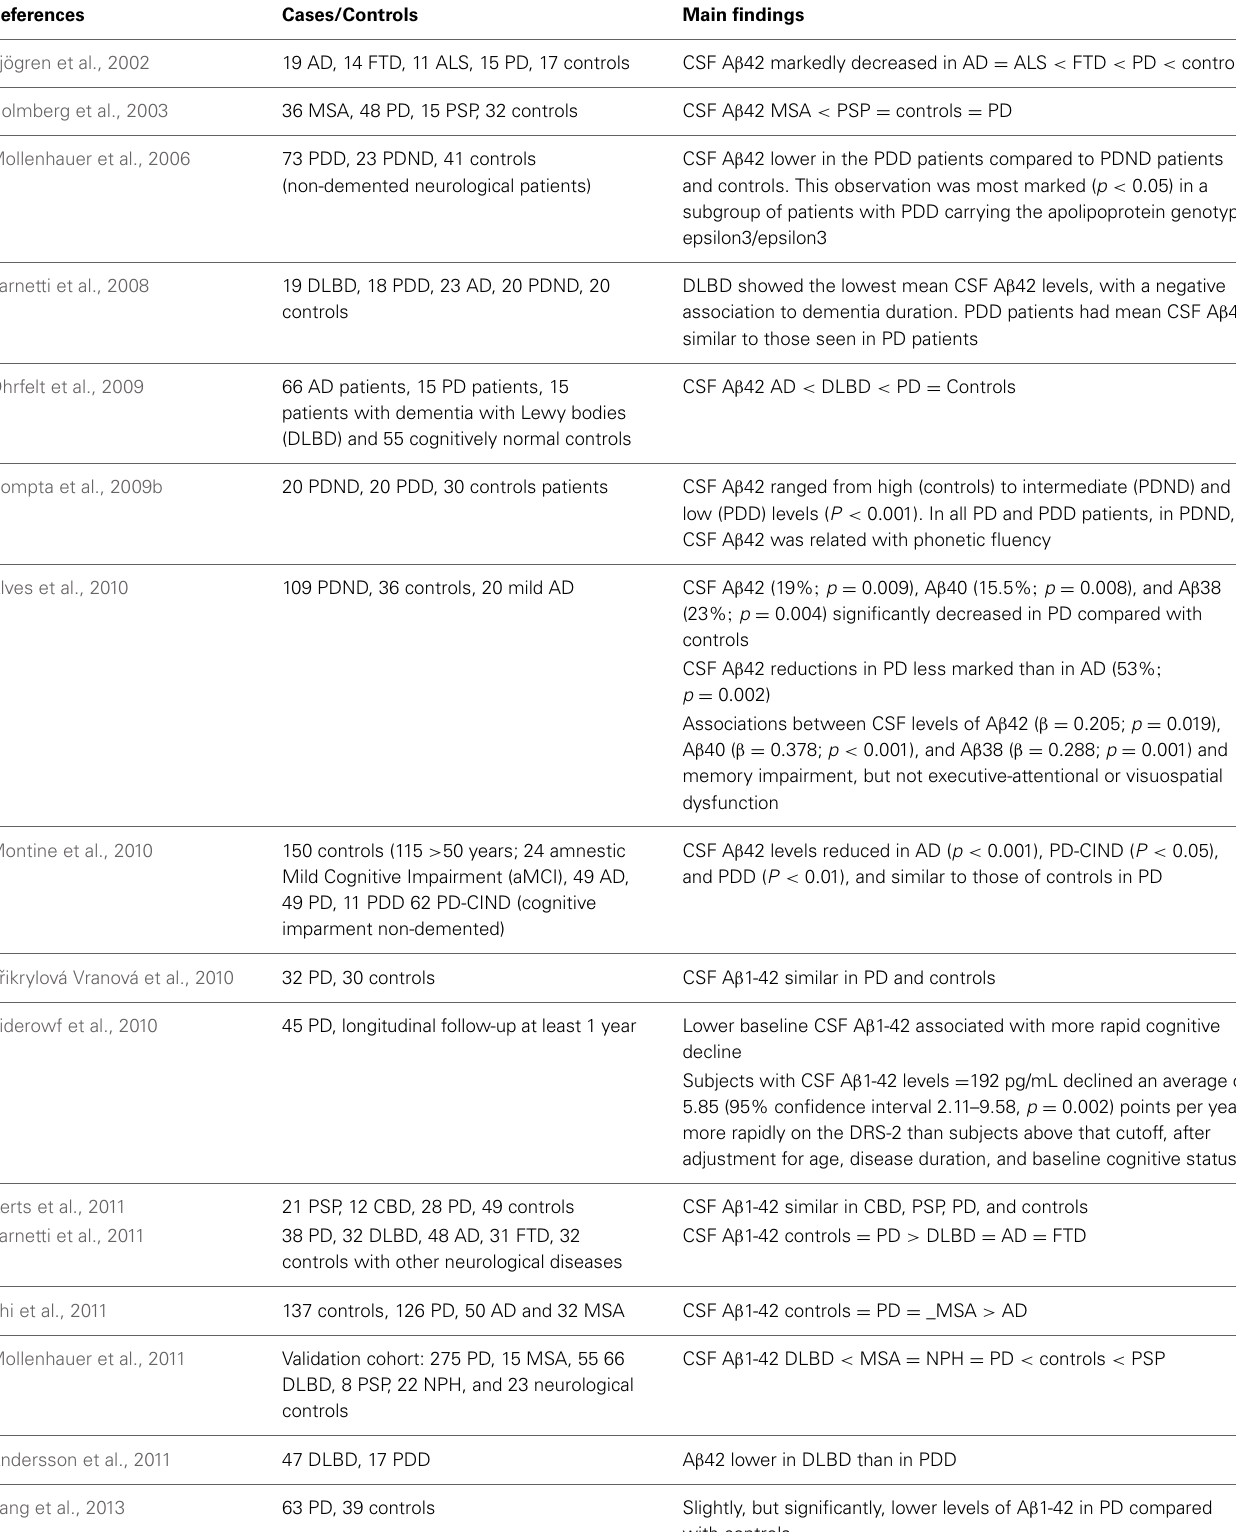
Table 6 | Results of studies on CSF amiloyd beta (A β ) levels in PD, other parkinsonian syndromes and